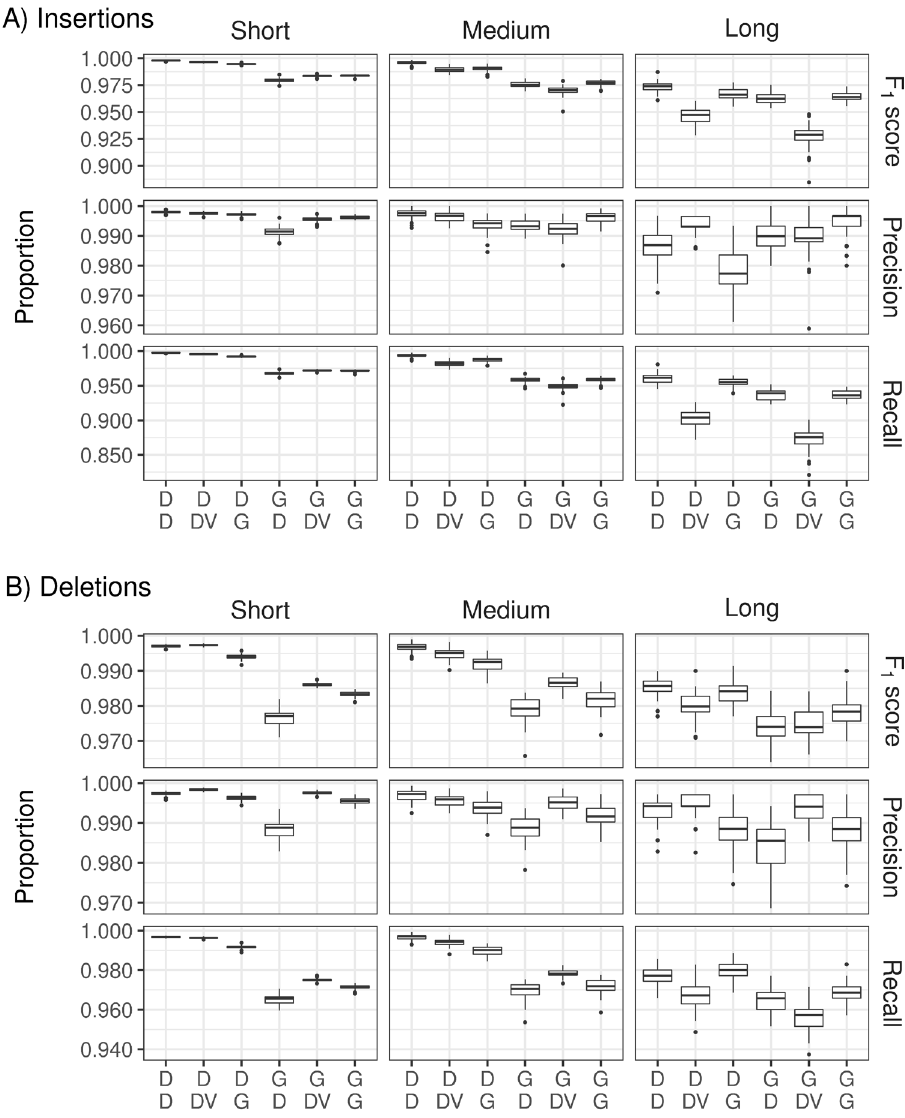
Figure 6. Percentages of F 1 score, precision and recall for deletions (upper part A ) and insertions (lower part B ) for short (1–5 bp), medium (6–15 bp) and long (> 15 bp) insertions/deletions for the 6 pipeline combinations, based on chromosomes 20–22 of the genome in a bottle sample HG003. Labels on the x-axis are defined in detail in Fig. 2. D DRAGEN, DV DeepVariant, G